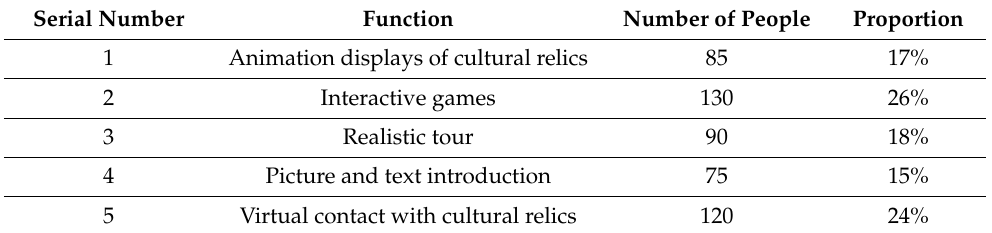
Table 1. Interactive digital museum functions expected by users.